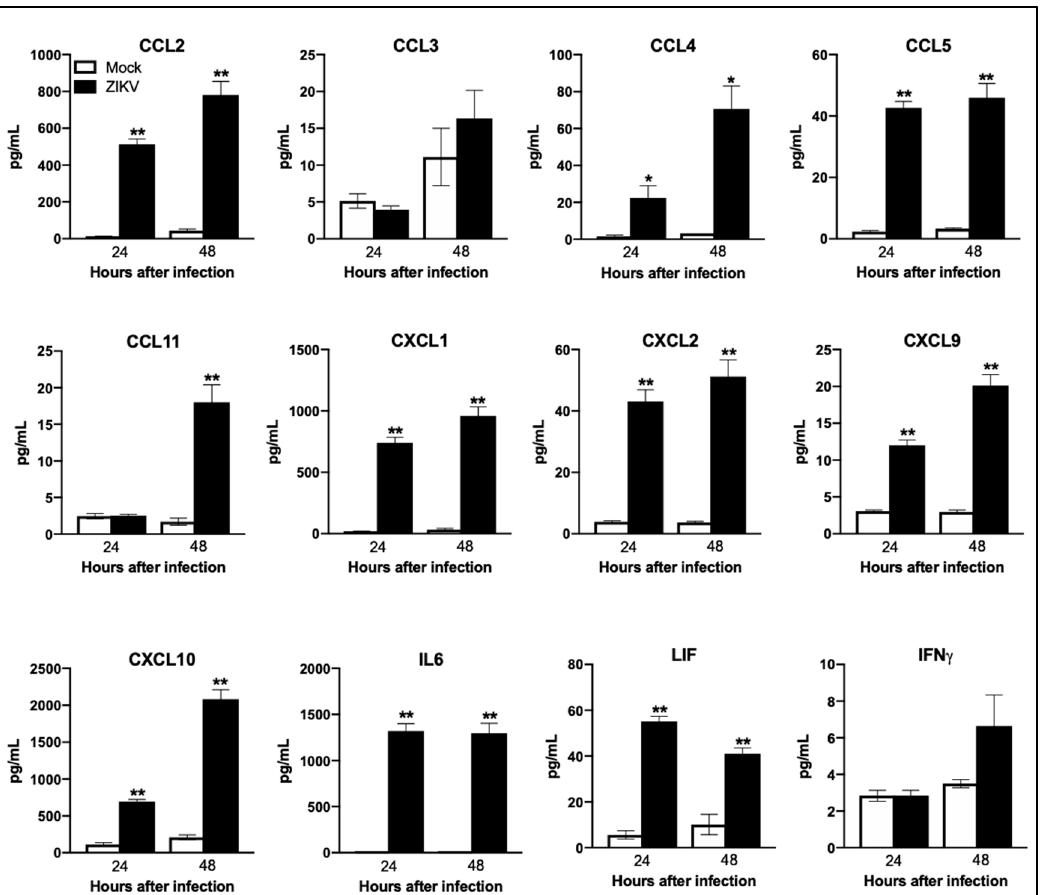
Figure 4. Enhanced production of cytokines and chemokines in ZIKV-infected neurons. Mouse cortical neuron cultures were infected with ZIKV (PRVABC59 strain) or PBS (Mock) at MOI-1 and supernatants were collected at 24 and 48 h after infection. Levels of chemokines and cytokines as noted in the figure were measured in cell supernatants using multiplex immunoassay and are expressed as the mean concentration (pg/mL) ± SEM. * p < 0.05, ** p < 0.001.